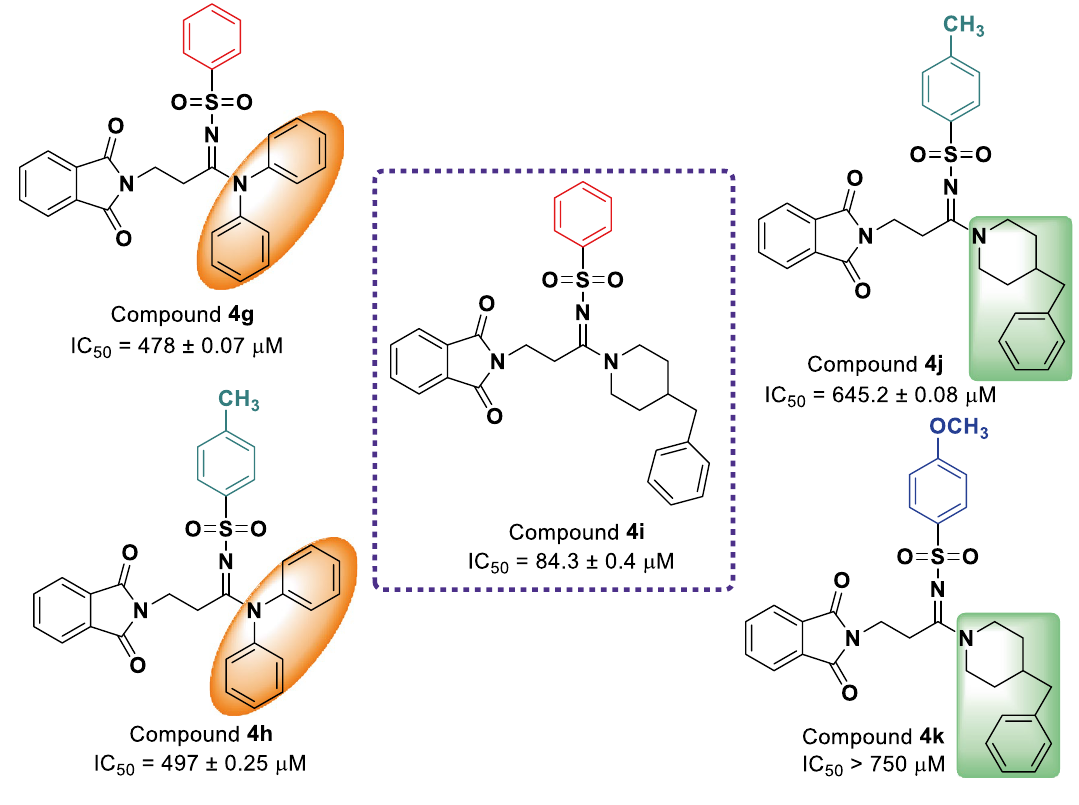
Figure 4. Comparison of α-glucosidase inhibitory activities of analogs 4g – k (ChemDraw 18.2).